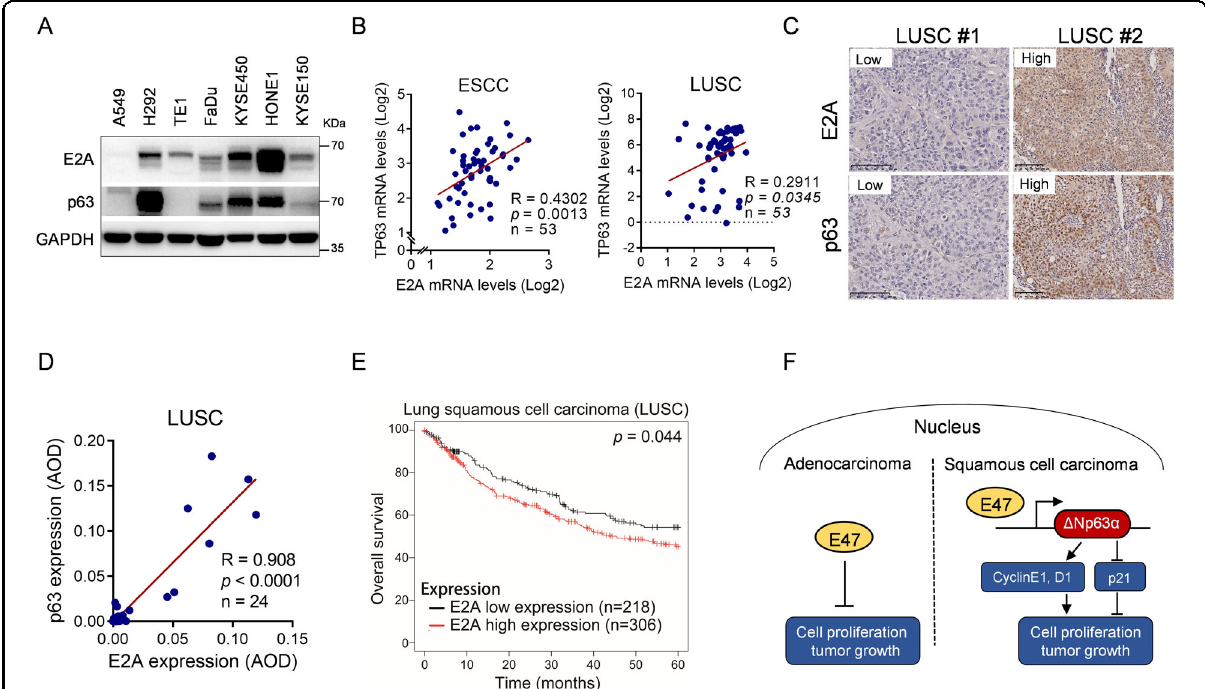
Fig. 4 E47 positively correlates with Δ Np63 α expression and its high expression is associated with poor overall survival in human lung squamous cell carcinoma. A Adenocarcinoma A549 and SCC H292, TE1, FaDu, KYSE450, KYSE150, or HONE1 cells were subjected to Western blot analyses. B The Oncomine datasets “ Su_Esophagus ” and “ Bild_Lung ” were used to analyze Pearson correlation of E47 (E2A) and p63 expression in ESCC and LUSC. C – D Consecutive tissue microarray slides derived from human lung squamous cell carcinoma (HLug-S030PG02) were subjected to IHC analysis for Pearson correlation of E47 (E2A) and p63. p63 antibody used here can recognize all isoforms of p63 (CY5659, Abways, Shanghai, China). Representative images were shown. Data were quanti fi ed by average optical density (AOD). Scale bar = 100 μ m. E Kaplan – Meier plots of overall survival of human squamous cell carcinoma patients were strati fi ed by the E2A mRNA expression levels in the patient tumor samples. F A working model depicting that the opposite roles of E47 on cell proliferation in adenocarcinoma and squamous cell carcinoma. E47 can function as a pro-oncogene by targeting Δ Np63 promoter to promote it transcription, resulting in promoting cell proliferation and tumor growth in lung squamous cell